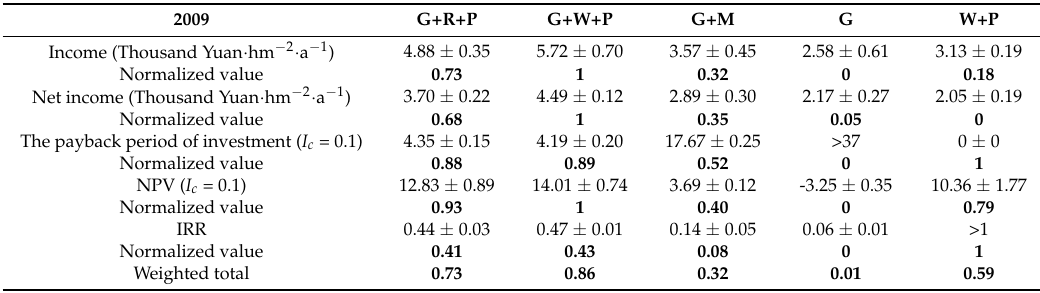
Table 5. Economic indicators in three mixed Ginkgo systems, pure Ginkgo (G), and a cropping system (W+P), in